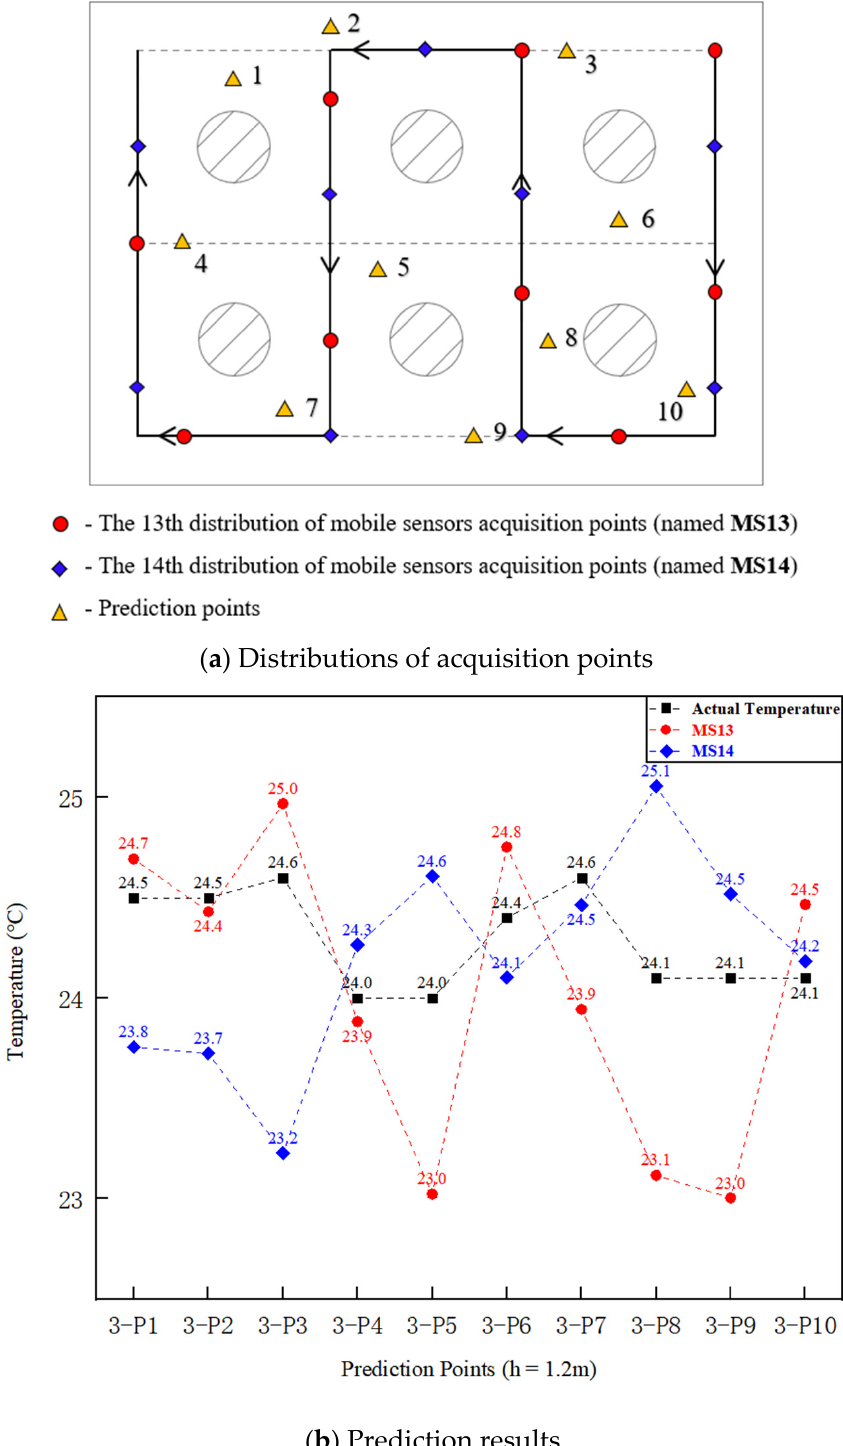
Figure 15. Prediction of mobile sensors with acquisition distance of 5.0 m. Table 4. Prediction of mobile sensors with different acquisition distances.